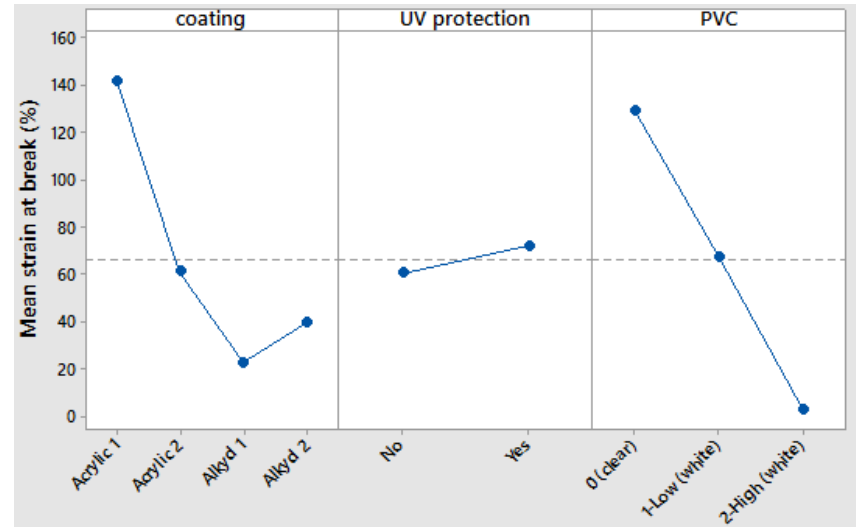
Figure 9. Main effects plot for the mean strain at break (room temperature).